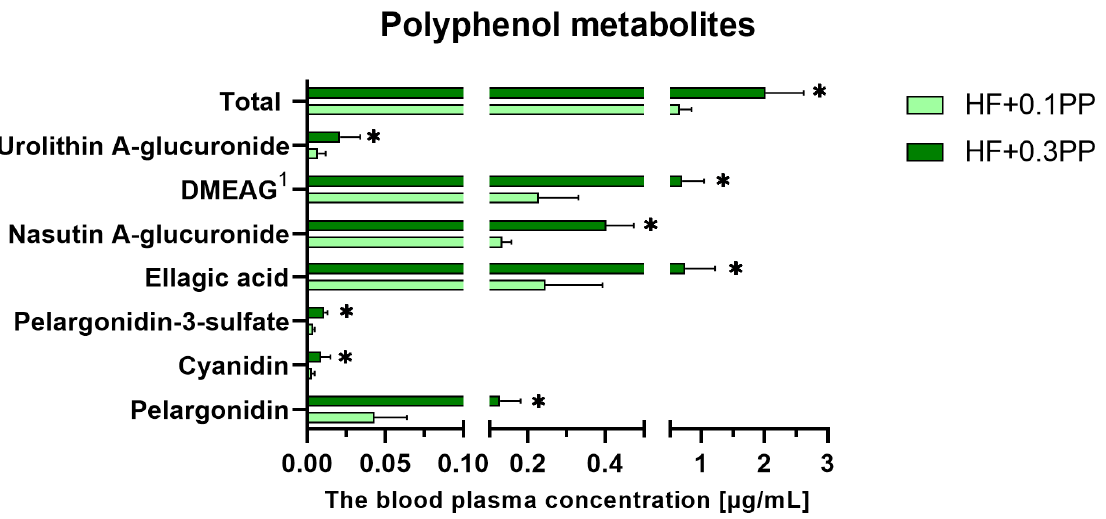
Figure 3. Blood plasma concentrations of polyphenolic metabolites in rats fed diets supplemented with raspberry extract. The values are the means ± SEMs. HF + 0.1PP, group fed a high-fat diet supplemented with 0.1% raspberry polyphenolic extract; HF + 0.3PP, group fed a high-fat diet supplemented with 0.3% raspberry polyphenolic extract. * Mean values are significantly different ( p < 0.05; t test). 1 ellagic acid dimethyl ether glucuronide.